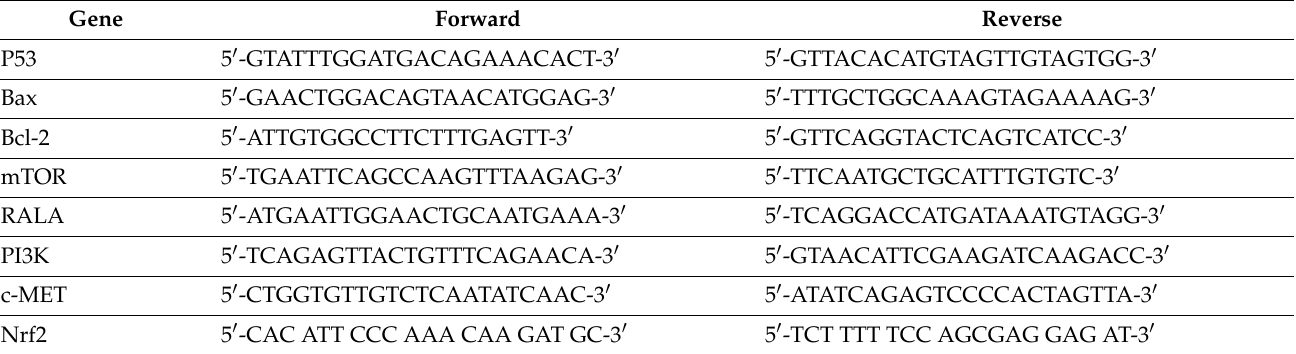
Table 1. Primers used for qRT-PCR. Sequences given in the 5 (cid:48) -3 (cid:48) direction. Gene Forward